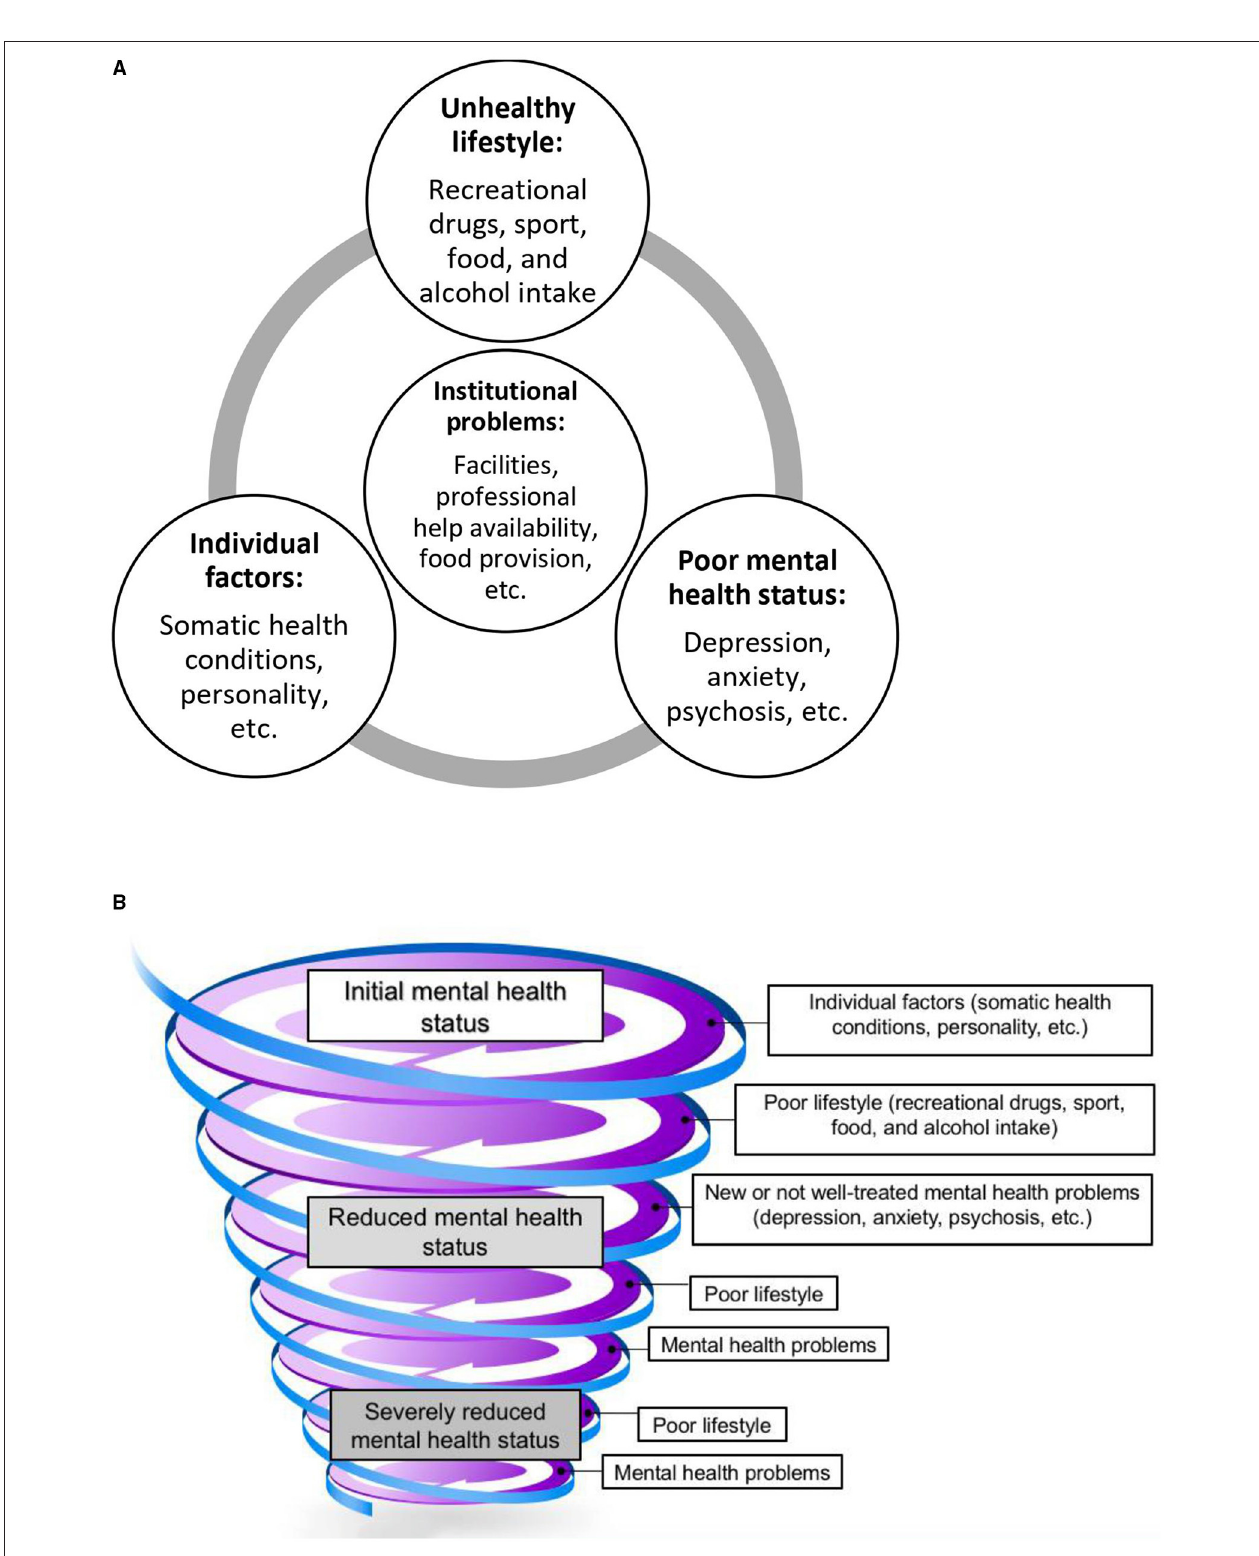
FIGURE 1 | Downward spiraling of unhealthy lifestyle and poor mental health. (A) Interactions between factors pertaining to mental health. (B) Downward spiraling.